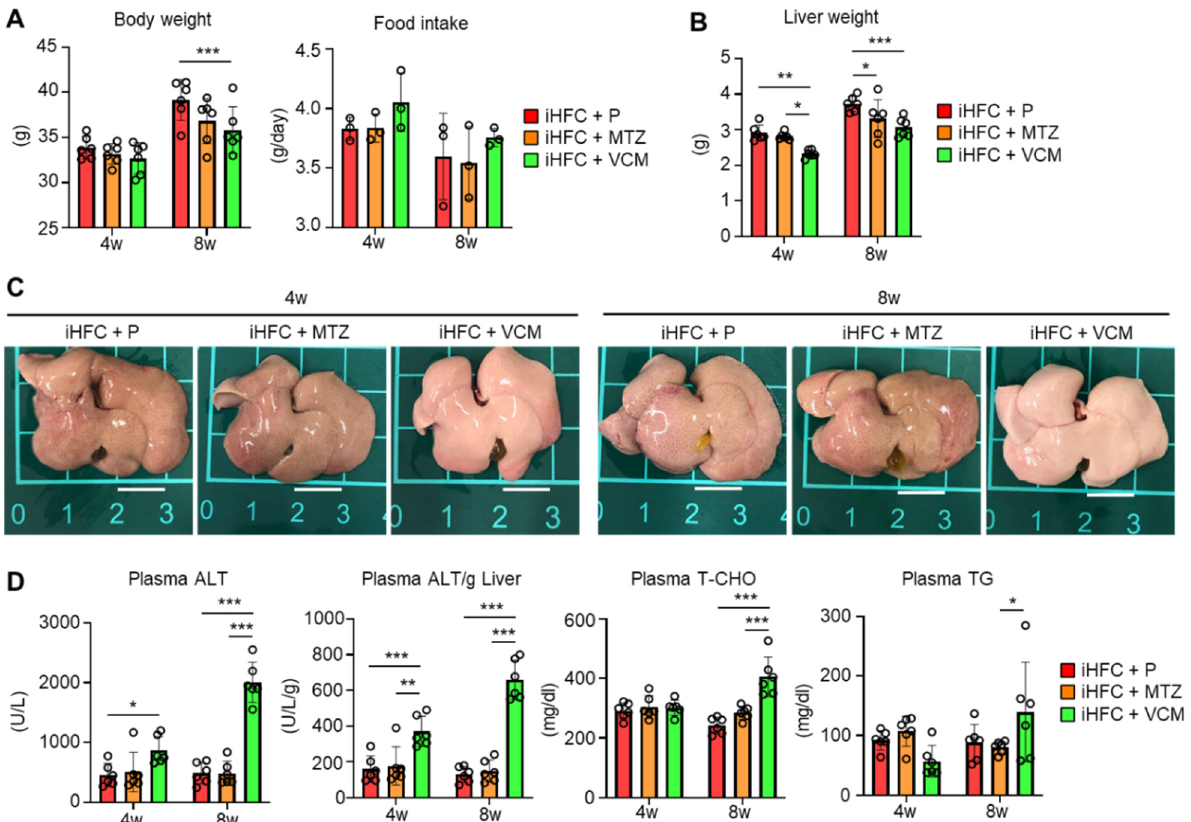
Figure 1. VCM treatment exacerbates liver damage in iHFC diet-fed Tsumura-Suzuki non-obese (TSNO) mice. ( A ) Body weights (n = 6 per group) and daily food intakes (n = 3 per group) were measured for placebo (iHFC + P)-, MTZ (iHFC + MTZ)-, or VCM (iHFC + VCM)-treated TSNO mice fed the iHFC diet. ( B ) Liver weights of placebo- or antibiotic-treated TSNO mice fed the iHFC diet (n = 6 per group). ( C ) Representative photos of the livers from placebo- or antibiotic-treated TSNO mice fed the iHFC diet. Scale bars, 1 cm. ( D ) Plasma ALT, T-CHO, and TG levels were measured (n = 6 per group). Plasma ALT levels per liver weight (g) were also calculated (n = 6 per group). Data are shown as means ± SD. * p < 0.05, ** p < 0.01, *** p < 0.001.